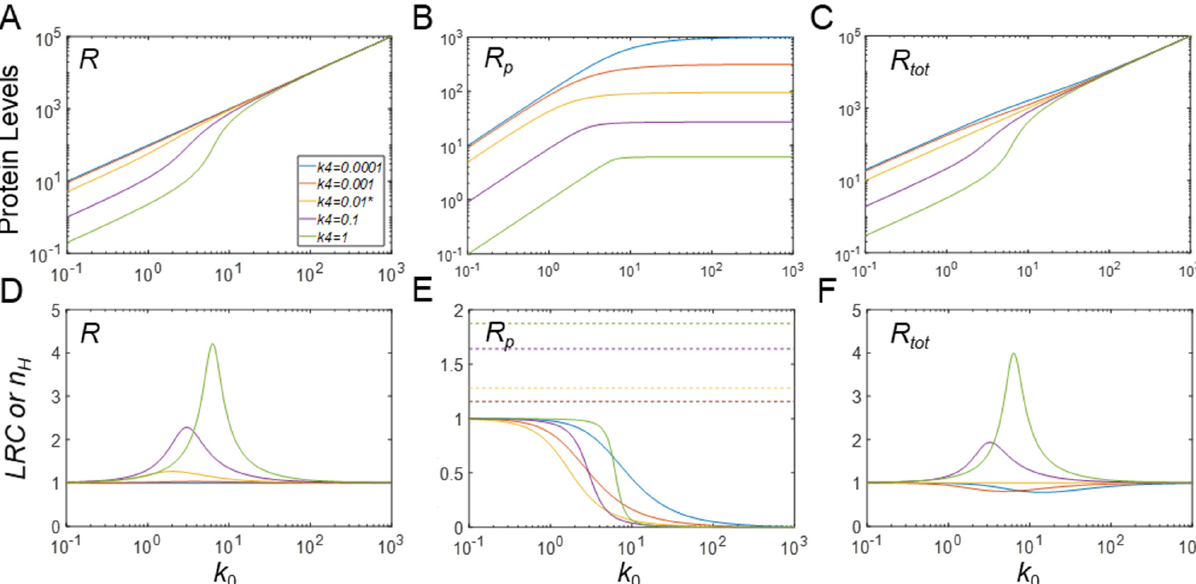
Figure 8. k 0 -driven ultrasensitivity with phosphorylation-induced changes in protein stability in the MM model. ( A – C ) Steady-state DR curves for R vs. k 0 , R p v.s k 0 , and R tot vs. k 0 , respectively, for different values of k 4 , as indicated in ( A ). The same color scheme for k 4 values is used for the other panels. ( D – F ) LRC (solid lines) and n H (dashed horizontal lines) for R , R p , and R tot . * k 4 = 0.01 is the default value. X = 1 for all conditions. Note that no n H was evaluated for R and R tot because the responses do not saturate.